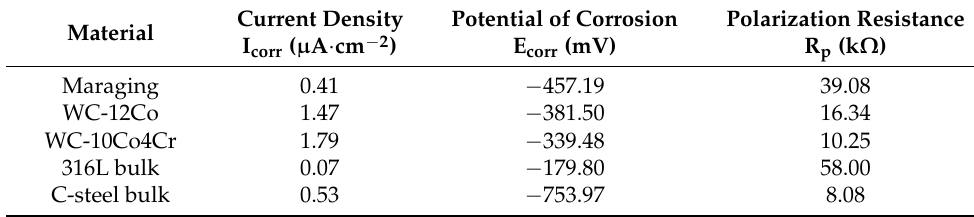
Table 5. Results of potentiodynamic